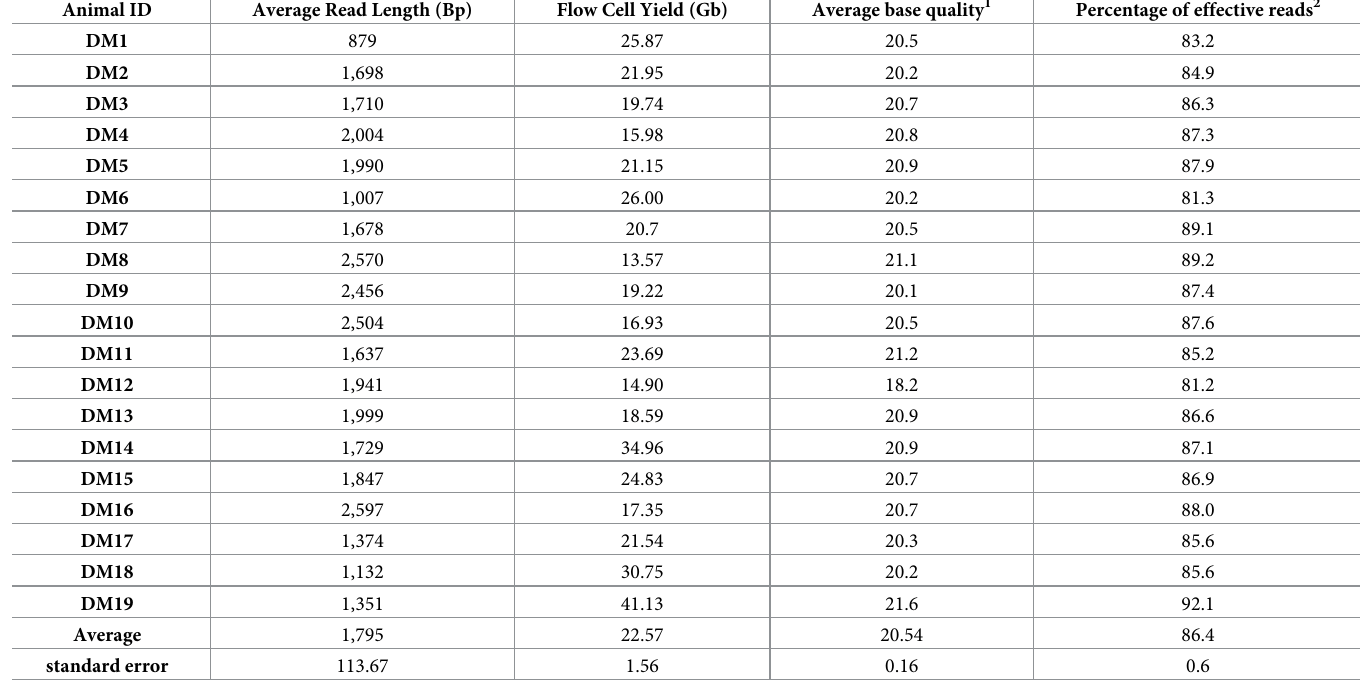
Table 1. Read length and flow cell yield for each sample sequenced on the MinION. Animal ID Average Read Length